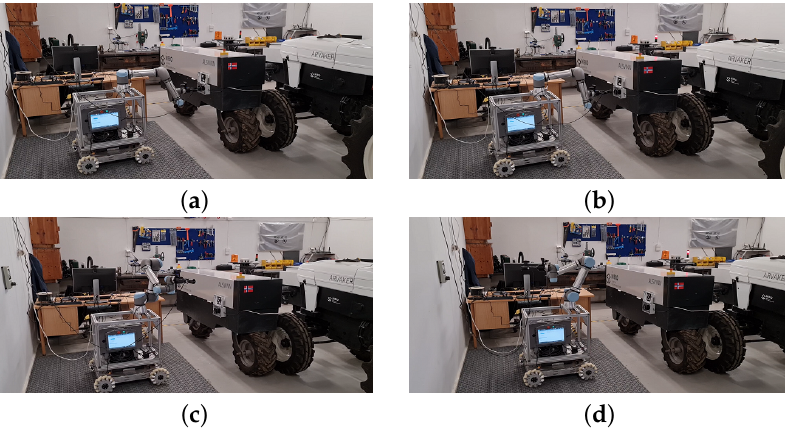
Figure 15. Sequence 4: Unplug the cable from the AEV. ( a ) Seq 4.1: Move the gripper to the approach point. ( b ) Seq 4.2: Close the gripper and move back to unplug the cable. ( c ) Seq 4.3: Turn the robot arm to face the wall-plug. ( d ) Seq 4.4: Face the wall-plug and initiate next sequence. The final sequence is to plug the charging cable back to the wall-plug. Similar to the first sequence, the ACS aligns first its MP to the wall-plug (Figure 16a), then proceeding with the centering step (Figure 16b), moving the gripper to the approach step (Figure 16c), and finally plugging the cable back to the wall-plug (Figure 16d).